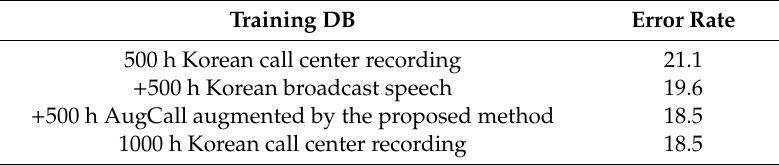
Table 6. Comparison of syllable error rate (%) for the call center recording speech recognition task, examining the models trained using AugCall, using additional Korean broadcast speech, and using an equal amount of call center recordings.